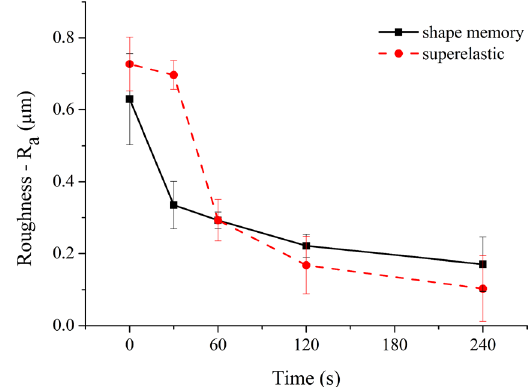
), measured by AFM, after a SO solution, at 2 4